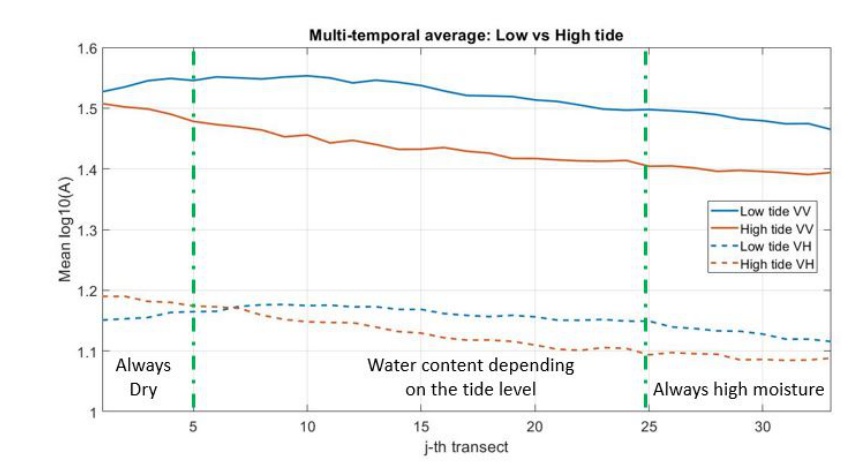
Figure 15. Multi-temporal amplitude mean: low and high tide trend for VH and VV polarizations. For both polarizations, in case of high tide (higher water level in the transects) the amplitude values are in general lower than the case of low tide (lower water